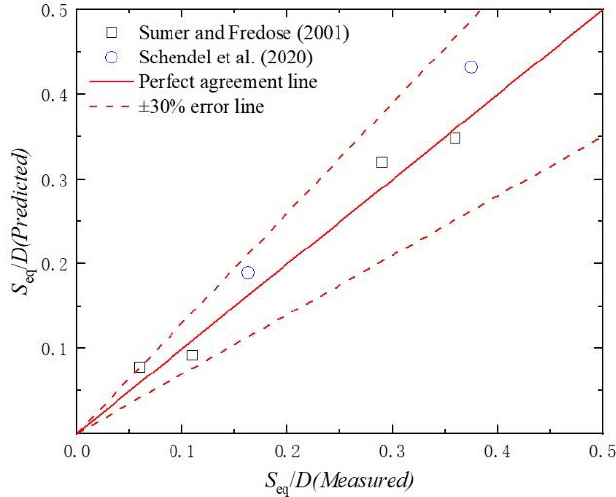
Figure 4. Comparison of the maximum or equilibrium scour depth between the present study and Sumer and Fredsøe [7], and Schendel et al. [33].